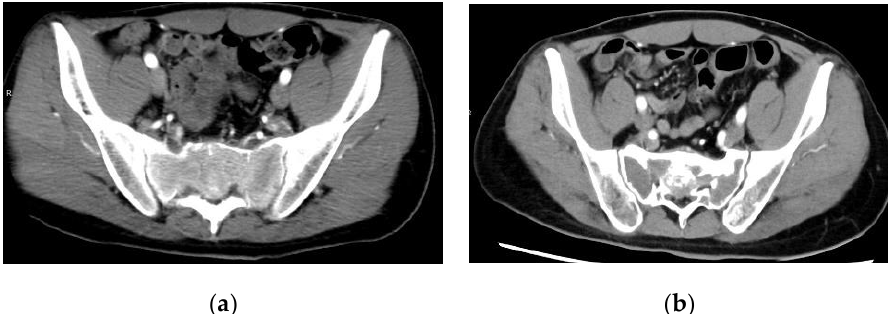
Figure 2. A case of sacral giant cell tumor of the bone treated with denosumab and embolization: ( a ) contrast-enhanced computed tomography at presentation showing osteolytic lesions of the sacrum and contrast-enhanced effects; ( b ) contrast-enhanced computed tomography showing bone sclerosis and loss of contrast effect 16 months after diagnosis, after 16 doses of denosumab and two sessions of embolization. The pain observed at presentation also improved. The patient experienced no complications related to denosumab therapy or embolization.